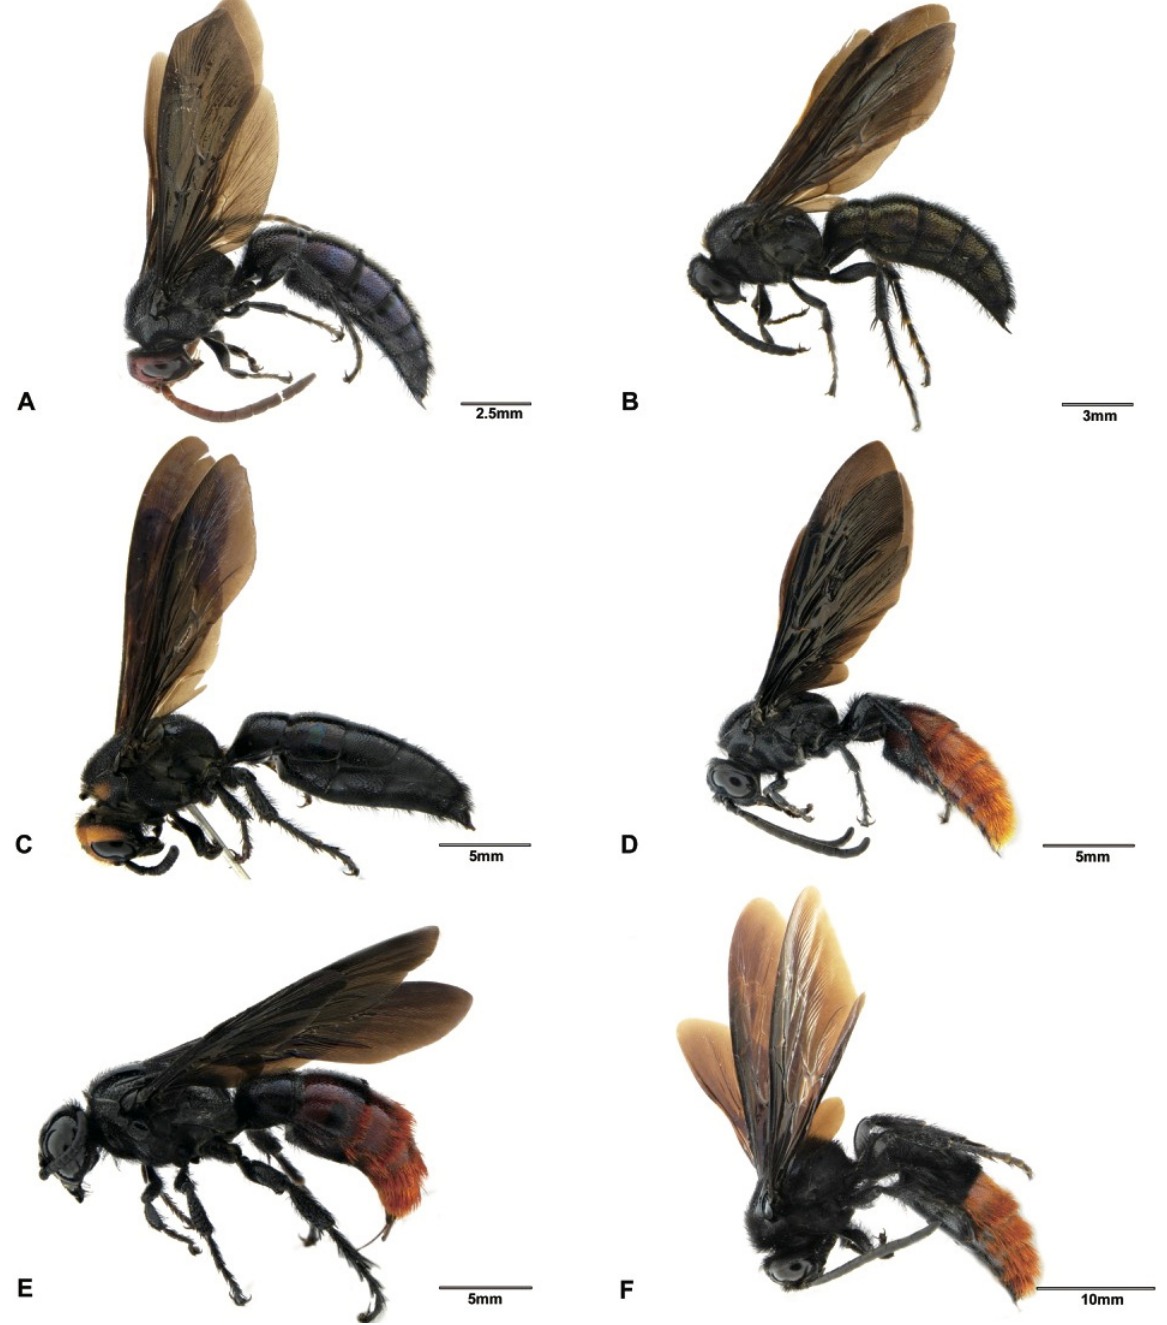
Figure 2. Habitus, lateral view. ( A ) Austroscolia ruficeps (Smith, 1855), male (SCAU3043675); ( B ) Carinoscolia vittifrons (Sichel, 1864), male (SCAU3043670); ( C ) Carinoscolia vittifrons (Sichel, 1864), female (SCAU3043672); ( D ) Liacos erythrosoma (Burmeister, 1853), male (SCAU3043662); ( E ) Liacos erythrosoma (Burmeister, 1853), female (SCAU3043661); ( F ) Megascolia azurea (Christ, 1791), male (SCAU3043666).